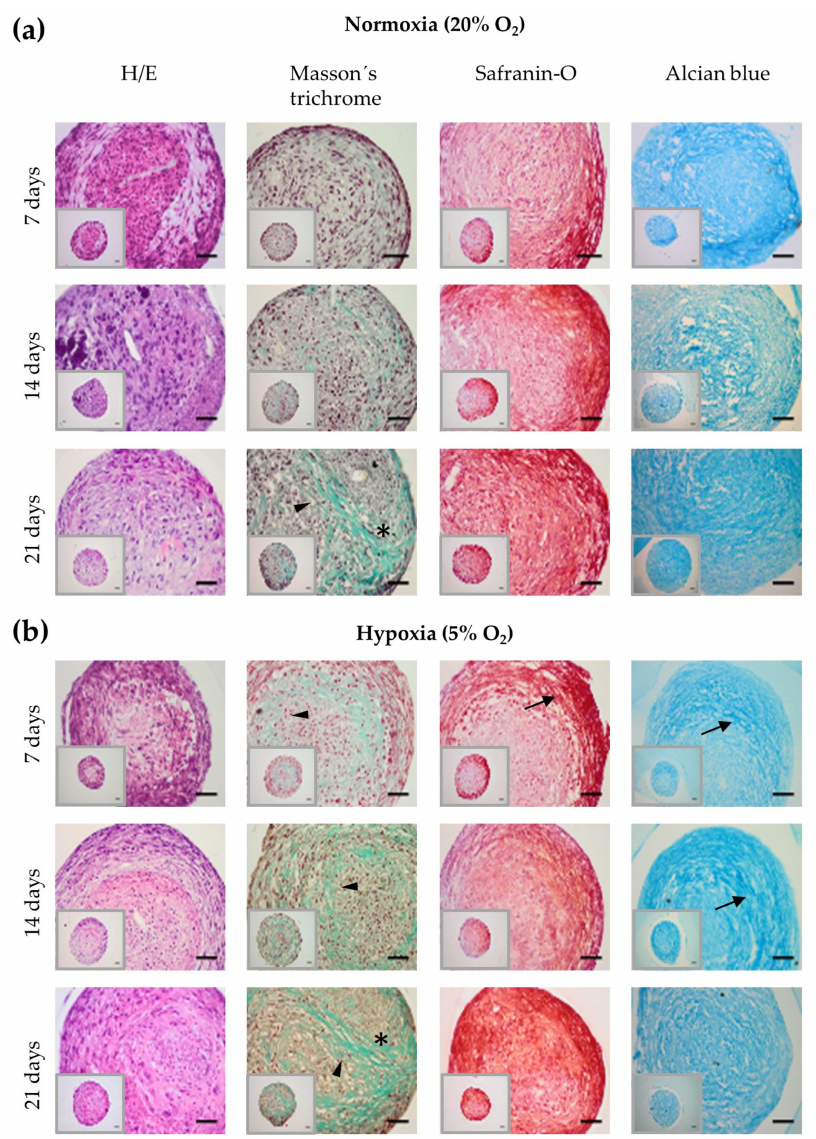
Figure 2. Bright field images of the histological sections obtained from chondrospheroids cultured at 7, 14 and 21 days under ( a ) normoxic and ( b ) hypoxic conditions stained with H / E, Masson’s trichrome, safranin-O and alcian blue ( n = 10 spheroids per time and culture condition). Central region of the spheroids (Masson’s trichrome): arrowheads mark collagen distribution and asterisks (*) mark chondrocyte-like cells surrounded by collagen fibers they had synthesized and secreted. Periphery of the spheroids (safranin-O and alcian blue): arrows mark sGAG distribution. The scale bar represents 50 µ